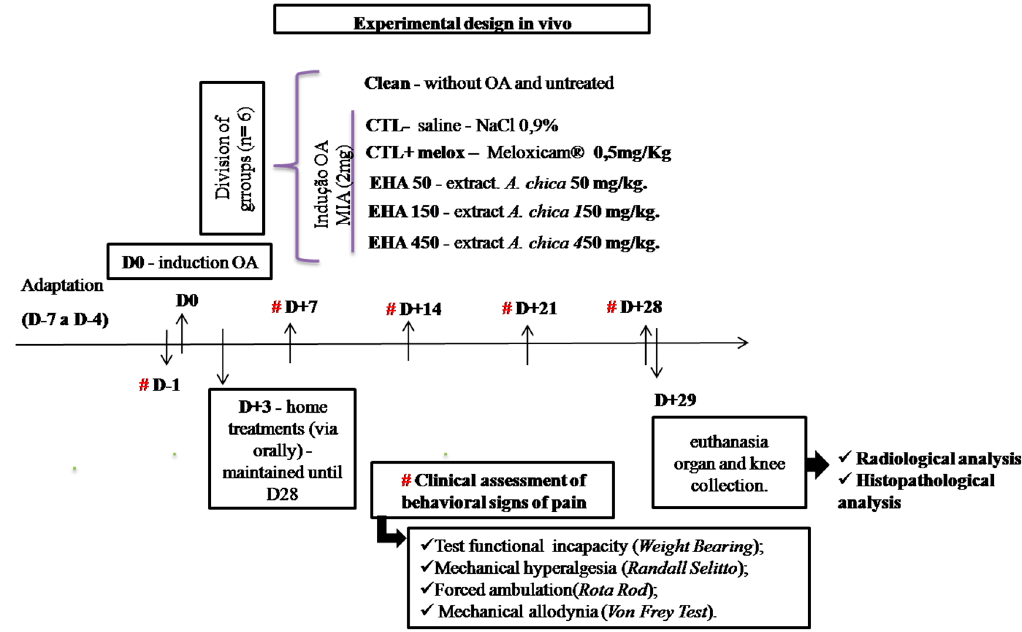
Figure 13. Experimental design.